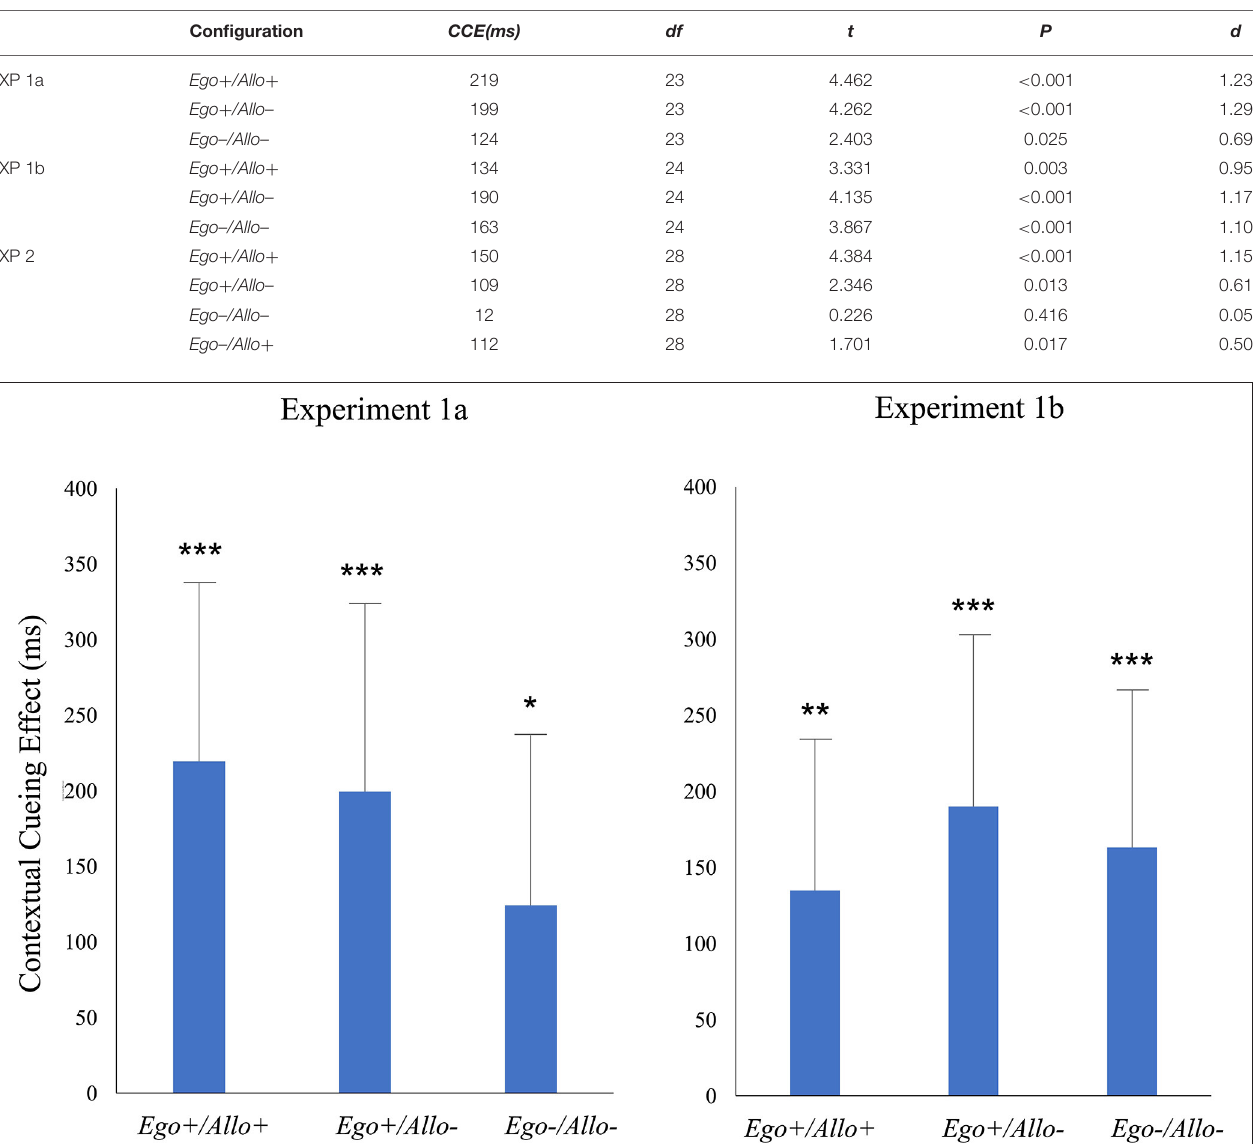
TABLE 1 | Comparisons between RT New - RT Repeated vs. zero in each configuration by one-tailed paired samples T -test. Configuration